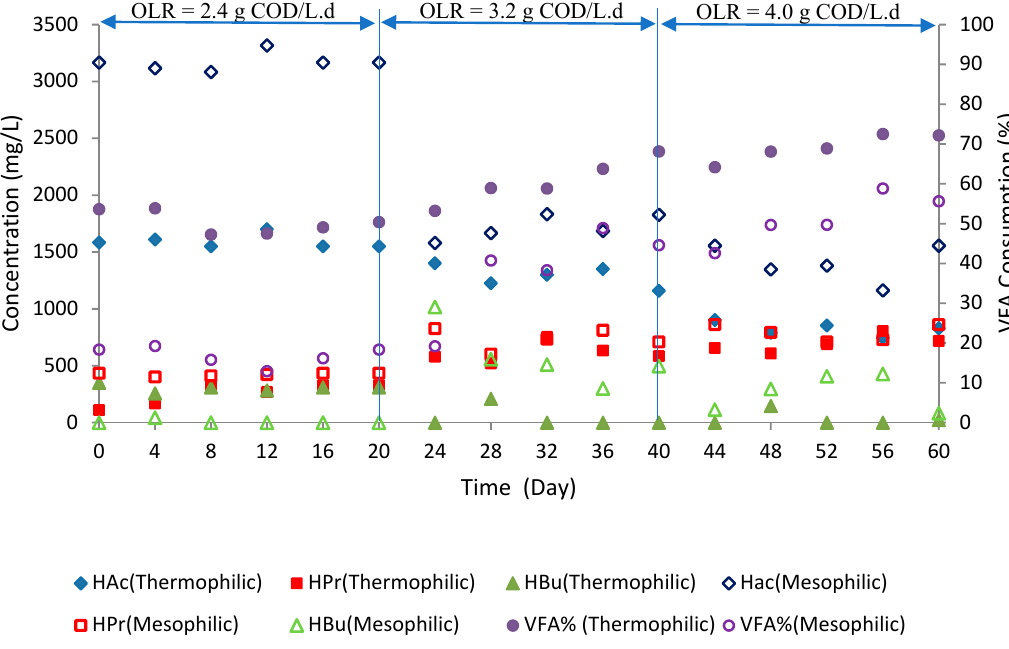
Figure 5. Volatile fatty acids (VFAs) concentration at various organic loading rates. Notes: Hac (Acetic acid); HPr (Propinoic acid); HBu (Butyric acid); VFA% (Volatile fatty acid consumption).